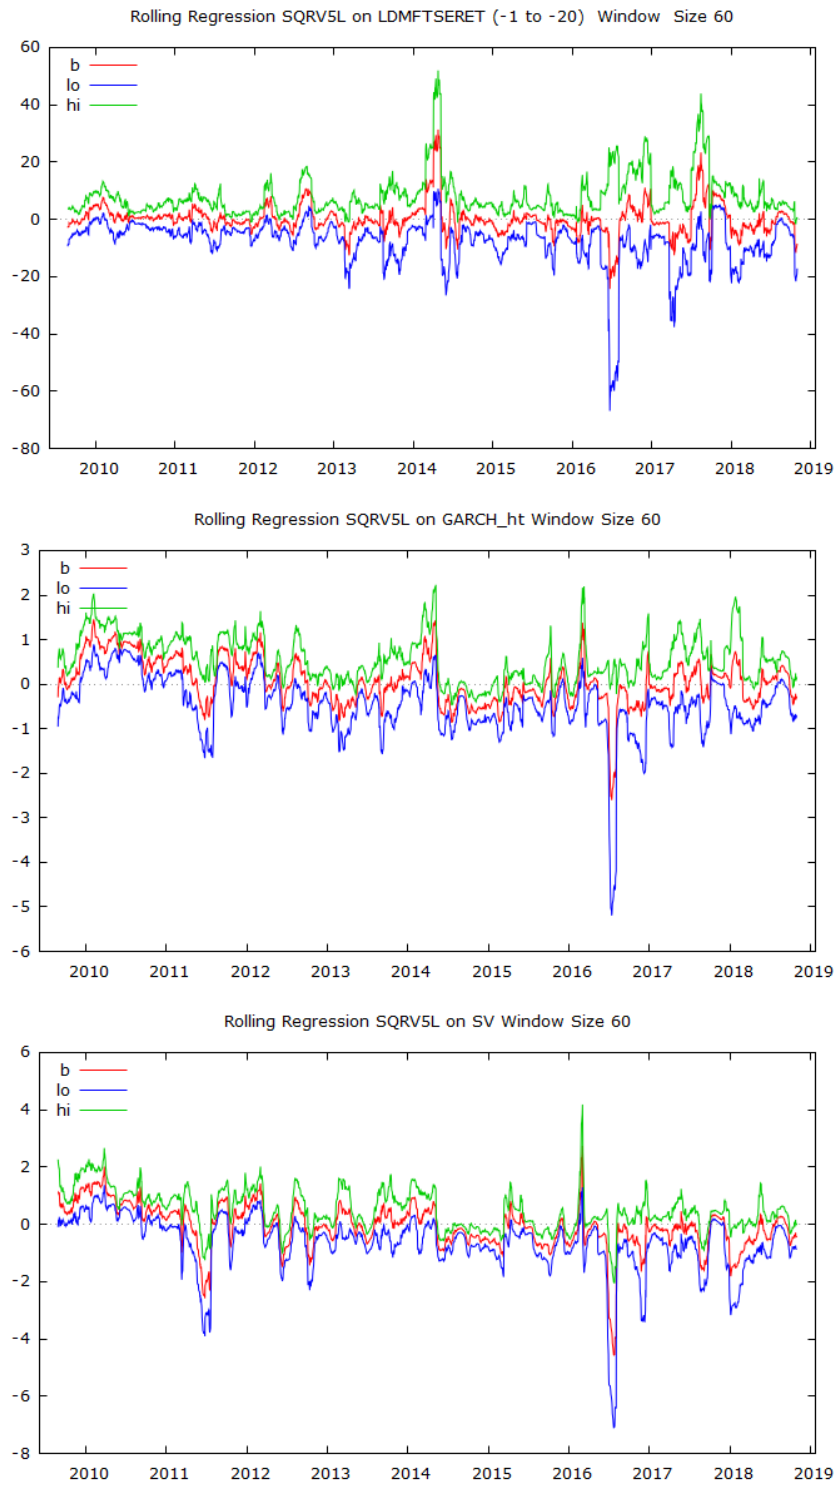
Figure A2. Rolling-regression—window size